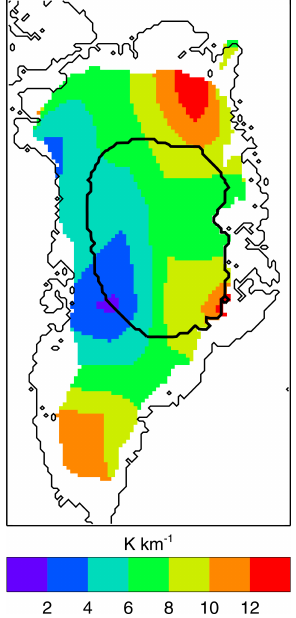
Figure D1. Change in surface air temperature divided by change in surface altitude (Kkm − 1 ) in the difference between the initial state of the experiment with HadGEM2-ES abrupt4xCO2 climate and low albedo and the state after 3600 years (Fig. 3b1, c1). The thick black line is the ice sheet edge in the latter